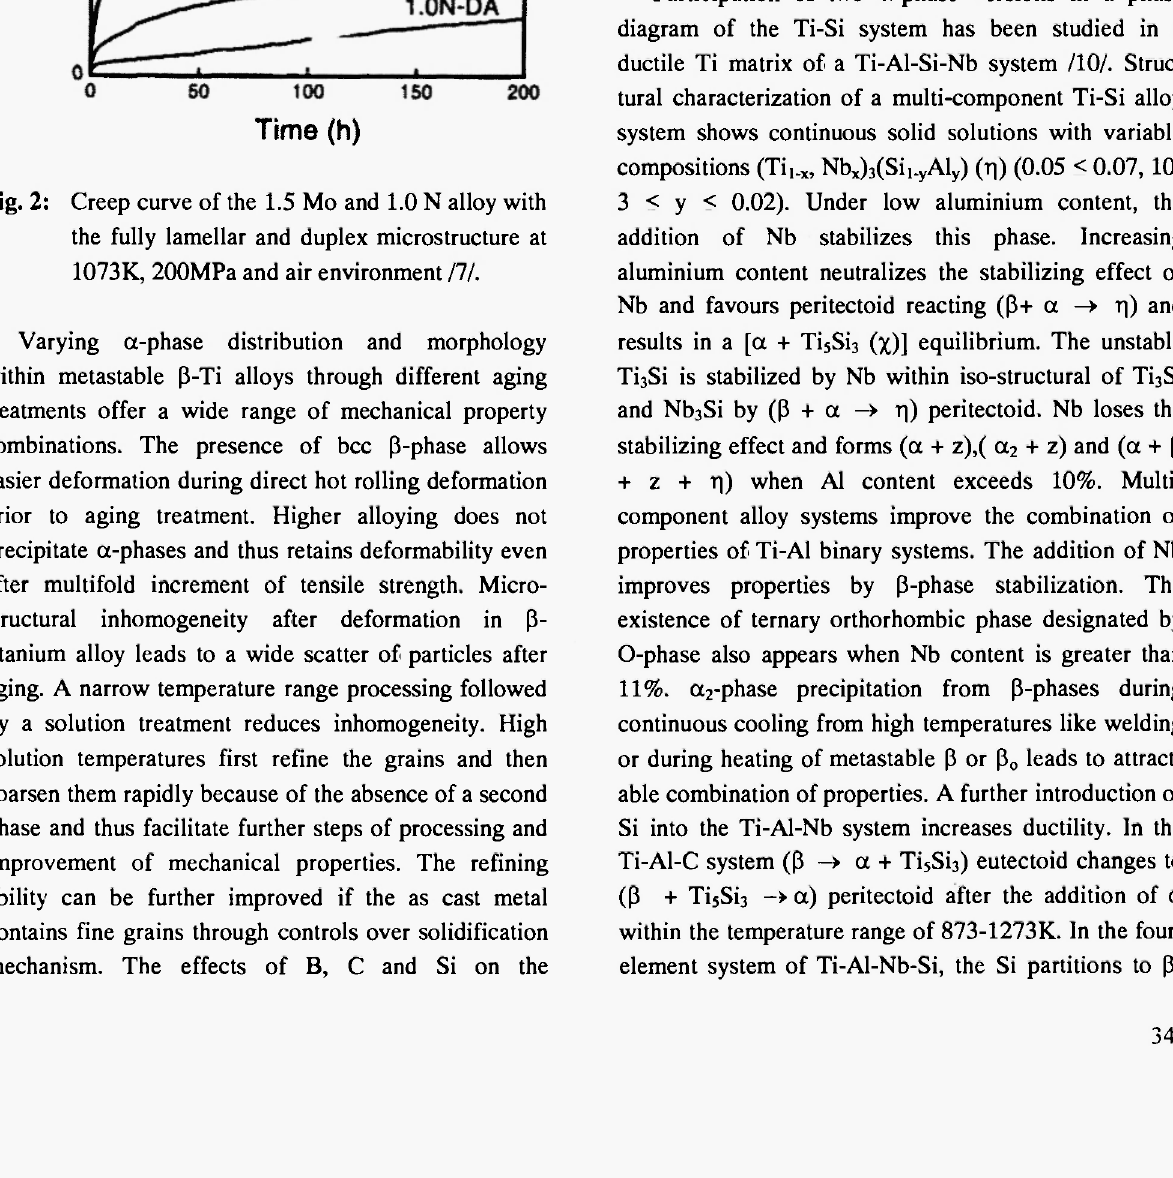
Fig. 2: Creep curve of the 1.5 Mo and 1.0 Ν alloy with the fully lamellar and duplex microstructure at 1073K, 200MPa and air environment